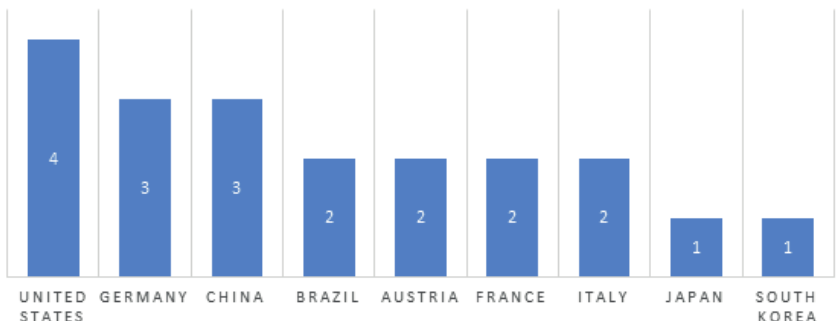
Figure 2 - Number of journal articles selected published by